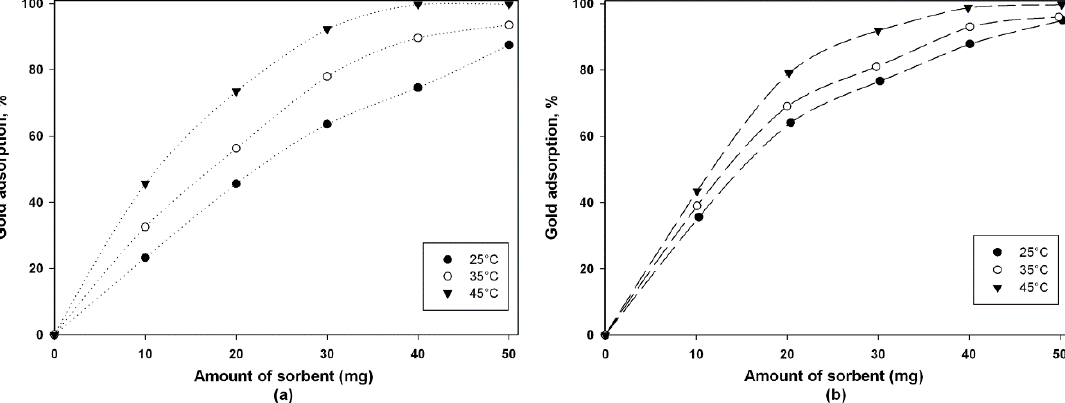
Figure 3. Gold adsorption (%) as a function of amount of sorbent by (a) ARH; (b) L-214 (60 min., 100 ppm, 100 rpm, pH = 6.1, and 10 mL